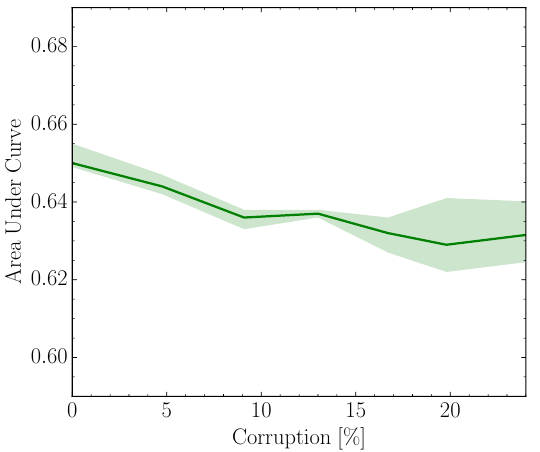
Figure 7. E(cid:11)ect of contaminating the training sample with an increasing fraction of signal events. The central line shows the overall AUC score, and the band represents the di(cid:11)erence between the upper and lower AUC